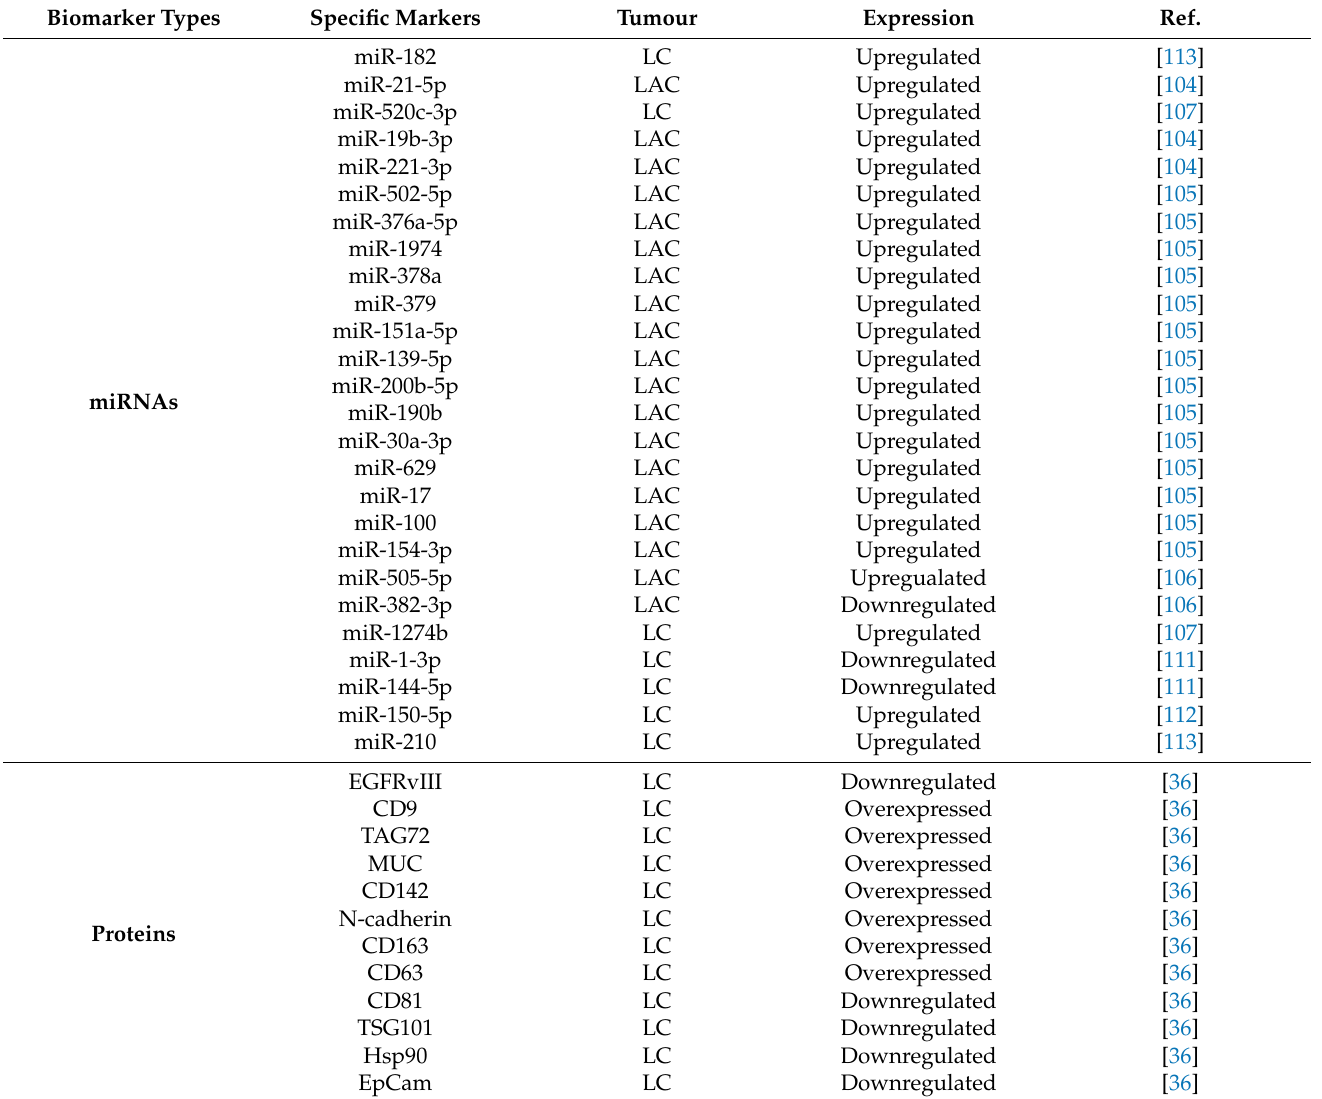
Table 5. EVs as potential biomarkers in lung